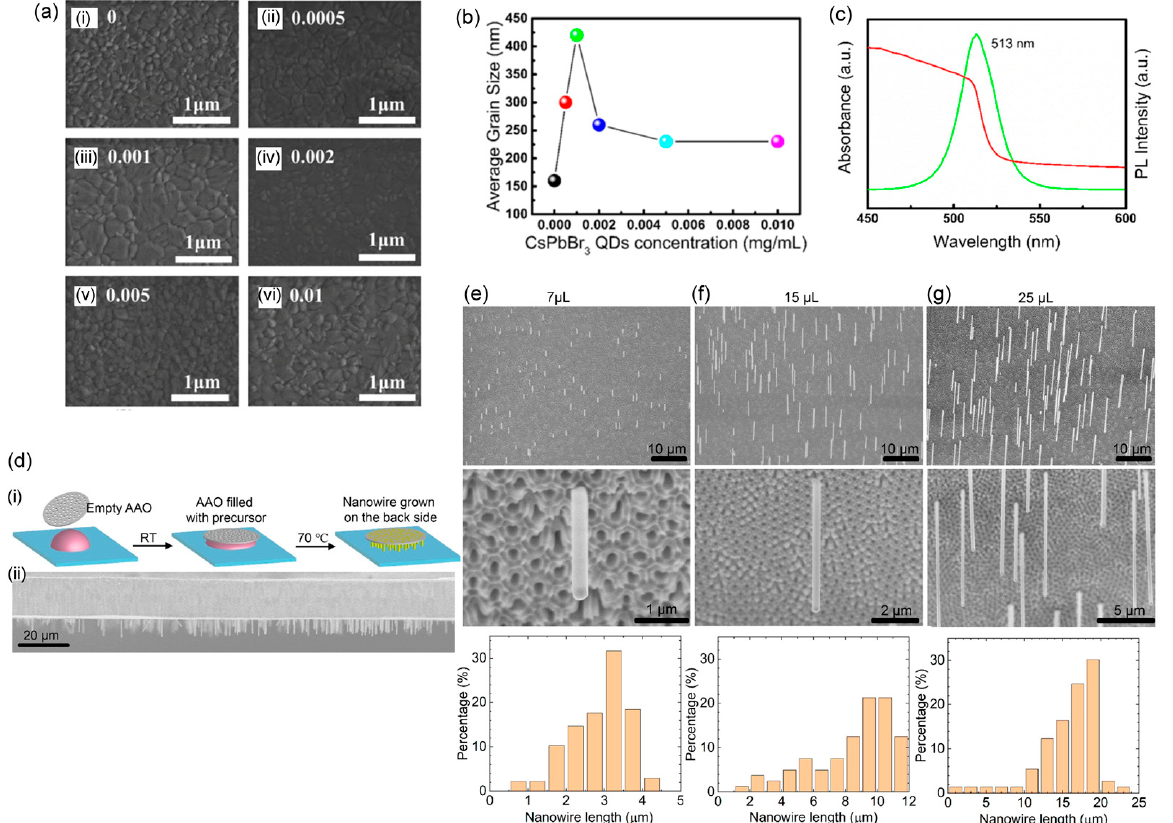
Figure 9. Heterogeneous nucleation effect on nanocrystals. ( a ) Top ‐ view SEM images of different concentrations (( i ) pristine; ( ii ) 0.0005 mg mL − 1 ( iii ) 0.001 mg mL − 1 ( iv ) 0.002 mg mL − 1 ( v ) 0.005 mg mL − 1 ( vi ) 0.01 mg mL − 1 of CsPbBr 3 QDs in diethyl ether, with scale bar 1 μ m. ( b ) Average grain size vs. different solution concentrations of CsPbBr 3 QDs from 0 to 0.01 mg mL − 1 . ( c ) UV ‐ vis absorption (red) and steady ‐ state PL spectra (green) for CsPbBr 3 QDs [148]. ( d ) Illustration of growth process ( i ) and cross ‐ sectional SEM images ( ii ); scale bar is 20 μ m of free ‐ standing CsPbBr 3 nanowires with back side of AAO template. SEM images and statistical distribution of the length of the free ‐ standing nanowire arrays, grown by using ( e ) 7 μ L, ( f ) 15 μ L, and ( g ) 25 μ L of precursor solution. The sample stage is tilted by 30° [149]. Reprinted with permission.